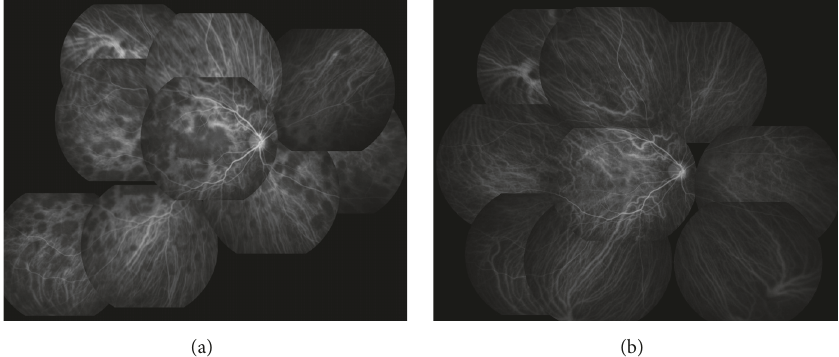
Figure 4: Indocyanine green angiography (ICGA) of the right eye. (a) At presentation showing loss of choroidal circulation with lesions remaining hypofluorescent in the early and late phases and even into the very late phase. (b) At 4 months after the initial examination. ICGA shows an almost complete resolution of the choroidal hypofluorescence.